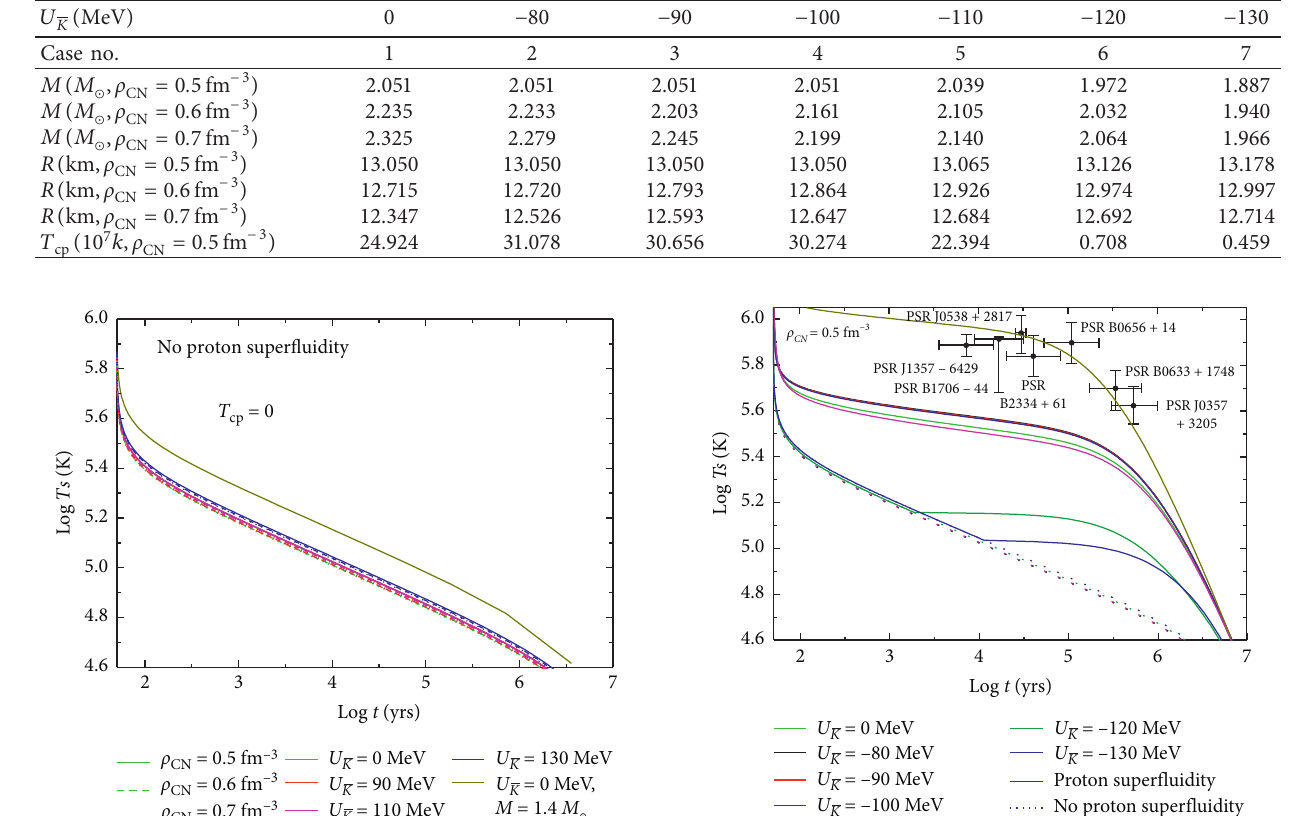
Table 1: Values of NS masses M and the corresponding radii R calculated for the center densities of ρ � 0, − 80, − 90, − 100, − 110, − 120, and − 130MeV. The critical temperature T potential of antikaons U K � 0 to − 130MeV and ρ � 0 . 5fm − 3 listed for U K CN